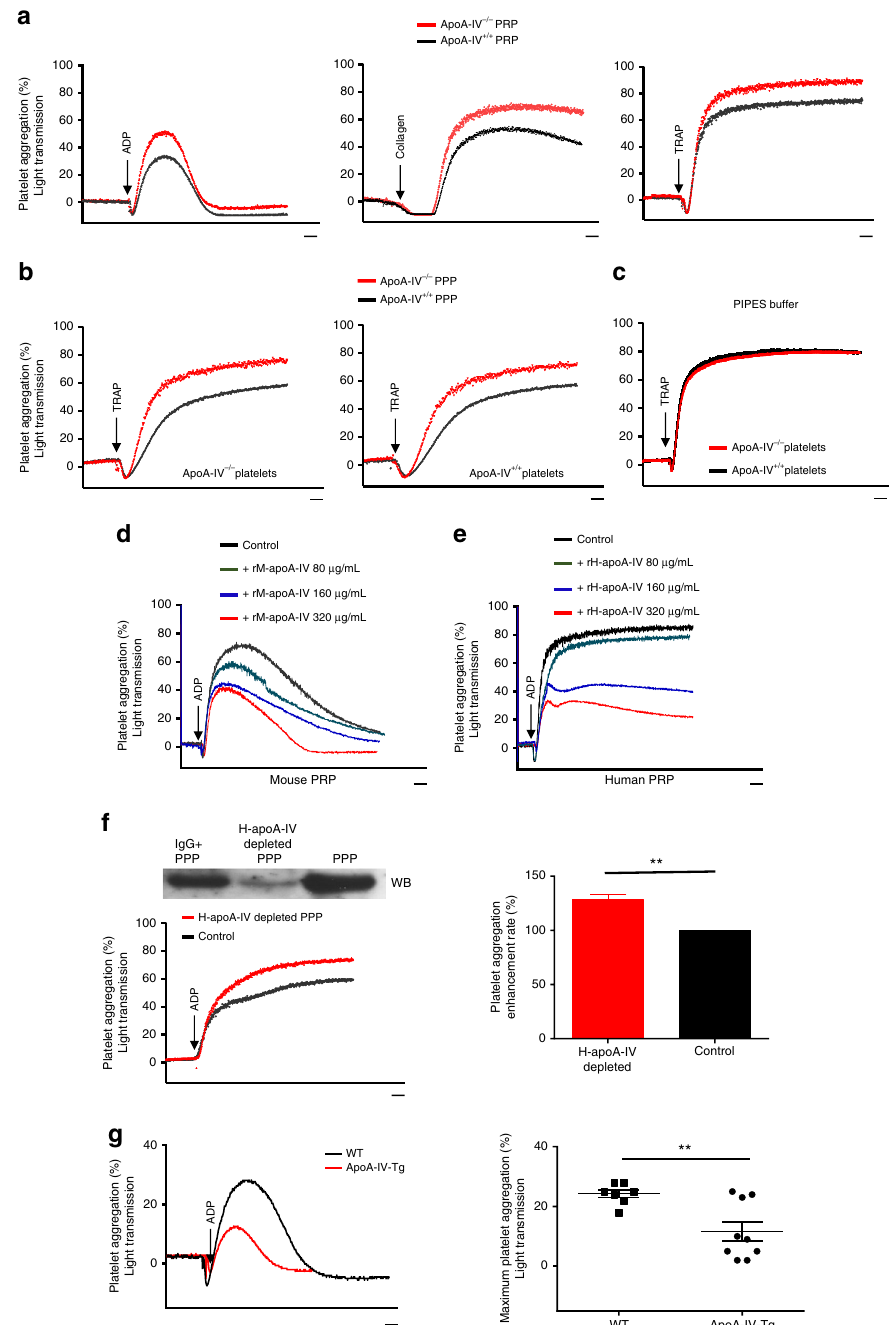
Fig. 3 ApoA-IV inhibits platelet aggregation in vitro. a Enhanced platelet aggregation in platelet-rich plasma (PRP) from apoA-IV − / − mice ( n = 5, P < 0.05) induced by ADP (1 μ M), collagen (1 μ g/mL) and TRAP (250 μ M). b Enhanced apoA-IV − / − and apoA-IV + / + platelet aggregation in apoA-IV − / − plasma ( n = 3, P < 0.05). ApoA-IV − / − and apoA-IV + / + platelet-poor plasma (PPP) were prepared and incubated with either ApoA-IV − / − or apoA-IV + / + gel- fi ltered platelets. Platelet aggregation was induced by TRAP (250 μ M). c No signi fi cant difference in aggregation between gel- fi ltered apoA-IV + / + and apoA-IV − / − platelets in PIPES buffer induced by TRAP (250 μ M) ( n = 3). d Dose-dependent inhibition of ADP (1 μ M) -induced platelet aggregation in mouse PRP by recombinant mouse apoA-IV. Areas under the curves for each group were compared to control ( n = 4, P < 0.05). e Dose-dependent inhibition of ADP (2.5 μ M) -induced platelet aggregation in human PRP by recombinant human apoA-IV ( n = 4, P < 0.05). f Depletion of human plasma apoA-IV from healthy donors with different ethnic backgrounds, by a goat anti-human apoA-IV IgG, enhanced ADP-induced platelet aggregation ( n = 4). Non-speci fi c goat IgG treated plasma was used as control. ApoA-IV-depleted PPP was shown by western blot (Supplementary Fig. 17). g Transgenic mice overexpressing mouse apoA-IV had markedly attenuated platelet aggregation induced by ADP (1 μ M) ( n = 4). Aggregation traces are representative of several independent experiments indicated. The maximum platelet aggregation in each group was compared to control unless otherwise indicated. PPP platelet poor plasma, rM-apoA-IV recombinant mouse apoA-IV, rH-apoA-IV recombinant human apoA-IV, ApoA-IV-Tg transgenic mice overexpressing mouse apoA-IV. Unpaired, two-tailed Student ’ s t-test or non-parametric Kruskal-Wallis one-way analysis of variance for multiple paired comparisons. Mean ± SEM. ** P < 0.01. Scale bars: 2 minute ( a – g ) NATURE COMMUNICATIONS| (2018) 9:3608 |DOI: